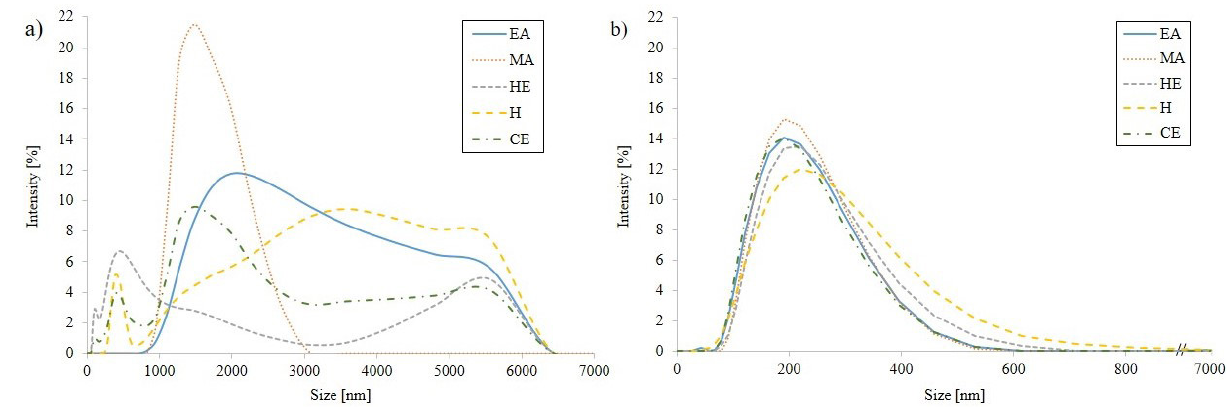
Figure 2: Size distribution of MLV (a) and SUV (b) populations. Intensity [%] stands for intensity distribution - the 1 st order result derived from dynamic light scattering measurement and represents the intensity distribution of particles sizes. The parameter is naturally weighted corresponding to the scattering intensity of each particle subpopulation/fraction.